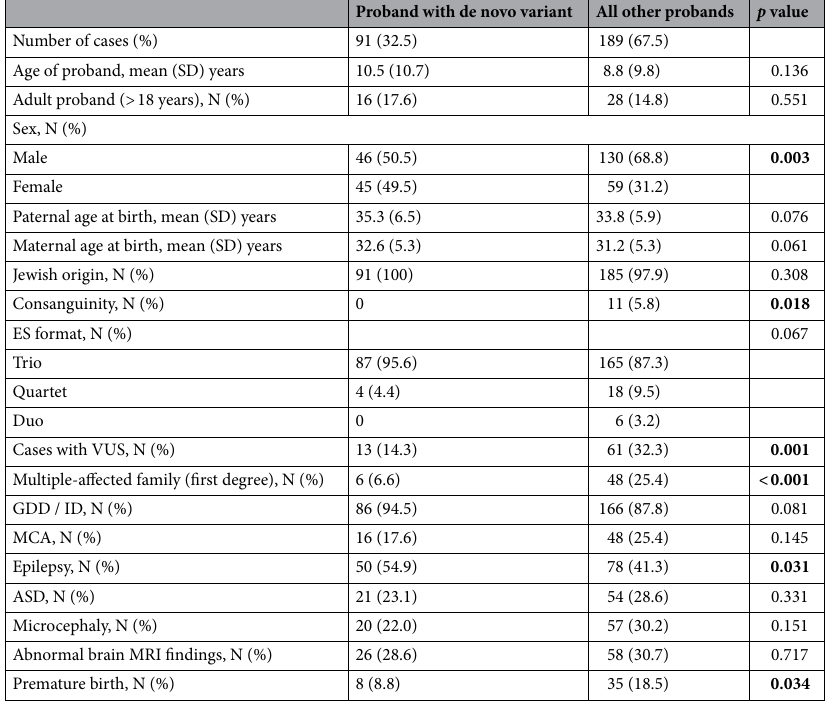
Table 2. Comparison between probands found to harbor a disease-causing de novo variant and all other probands (undiagnosed or diagnosed with non de novo variant). Statistically significant values ( p < 0.05) are given in bold. ASD, autism spectrum disorder; ES, exome sequencing; GDD, global developmental delay; ID, intellectual disability; MCA, multiple congenital anomalies; MRI, magnetic resonance imaging; N, number; NDD, neurodevelopmental delay; SD, standard deviation; VUS, variant of uncertain